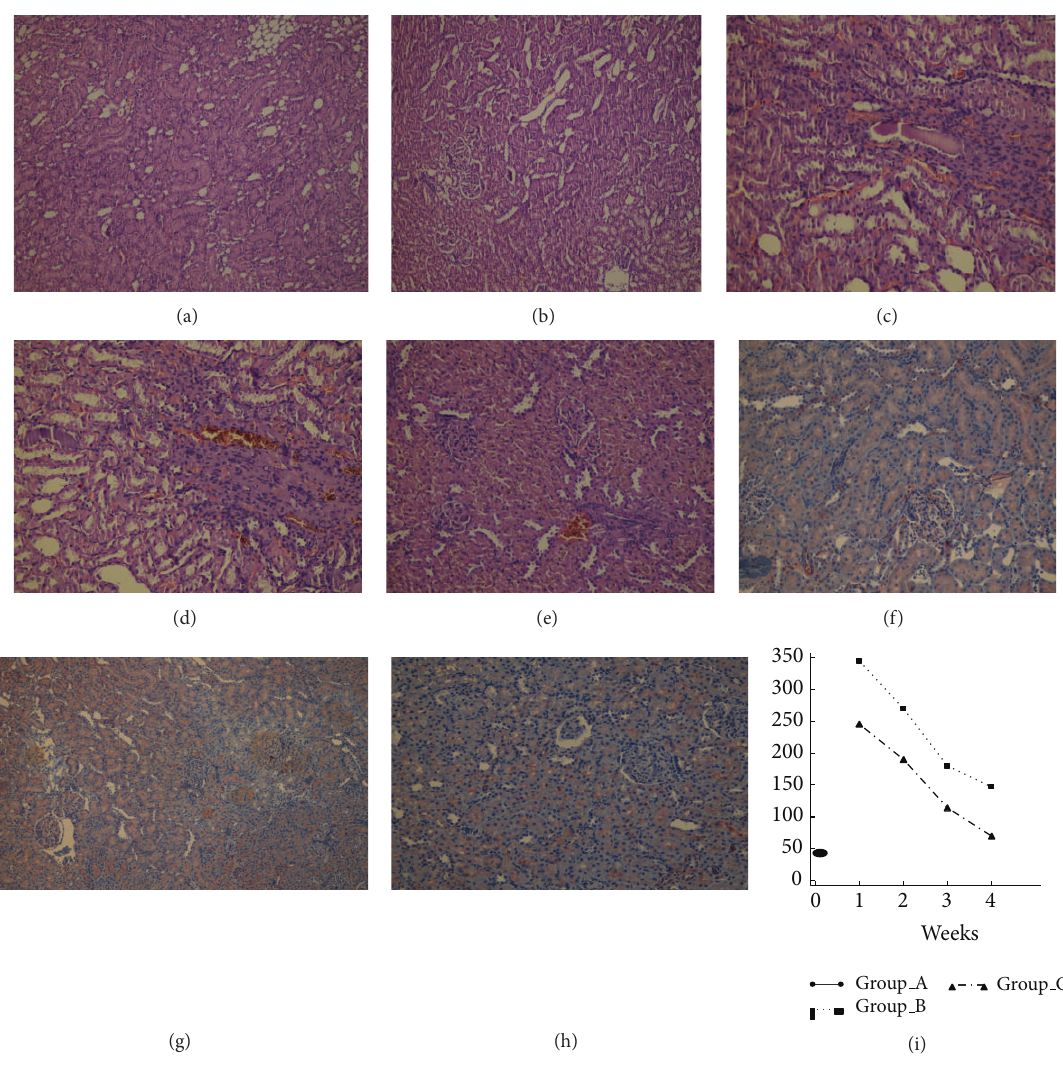
Figure 3: (a) (Group B) and (b) (Group C): the necrotic area was more intense in Group B than in Group C (H&E, × 200). (c) (Group B): chronic pyelonephritis in Group B with increased fibrosis and tubular hyalinization in tubules (H&E, × 200). (d) (Group B) and (e) (Group C): in Group B, there was increased intertubular inflammation and fibrosis and tubular atrophy (chronic pyelonephritis), but no chronic pyelonephritis was observed in Group C (H&E, × 200). (f) (Group A): weak e-NOS expression in proximal and distal tubular cytoplasm (eNOS, × 200). (g) (Group B) and (h) (Group C): proximal and distal tubular cytoplasmic weak positivity of e-NOS expression was